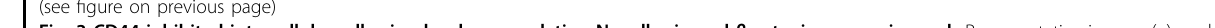
Fig. 3 CD44 inhibited intercellular adhesion by downregulating N-cadherin and β -catenin expression. a , b Representative images ( a ), and quanti fi cation ( b ) of heterotypic intercellular adhesion (hetero adhesion), heterotypic cell clustering (hetero cluster) formed between CCRF-CEM (red) and isogenic cells, and homotypic cell clustering (homo cluster) formed between isogenic tumor cells. Heterotypic adhesion = CCRF-CEM adhered to PLC/PRF/5/total PLC/PRF/5 cells. For heterotypic cluster, the cluster rate = cells in cluster/total cells, the CCRF rate = CCRF-CEM in cluster/total CCRF- CEM, and the CCRF/PLC = CCRF-CEM in cluster/total PLC/PRF/5. Homotypic cluster = percentage of PLC/PRF/5 cells in cluster. The cell cluster was de fi ned as a cell colony that contains >6 cells. Scale bar = 50 μ m. Data are means ± SD of six images of 20× objective. n > 1000 cells analyzed for each cell. * P < 0.05; ** P < 0.01; *** P < 0.001; **** P < 0.0001. c Expression of adhesion molecules upon CD44 overexpression or CD44 knockdown detected by Western blot. The β -actin was used as a loading control. d Interaction between N-cadherin and β -catenin analyzed by co-immunoprecipitation blot. e Representative images depict the subcellular localization of N-cadherin (green), β -catenin (red), and CD44 (purple) in PLC/PRF/5 cells by confocal microscopy. Scale bar, 10 µm. f The relative fl uorescent intensity on line 1 and line 2 in e quanti fi ed by line scanning. g Images showing heterotypic intercellular adhesion (hetero adhesion) and heterotypic cell clustering (hetero cluster) formed between CCRF-CEM (red) CD44-depleted F6ft cells with β -catenin co-depletion. Scale bars, 50 μ m. h N-cadherin and β -catenin mediate enhanced heterotypic intercellular adhesion (hetero adhesion), heterotypic cell clustering (hetero cluster), and heterotypic CIC formation (hetero CIC) upon CD44 depletion. Data are means ± SD of six images of 20× objective. n > 1000 cells analyzed for each cell. ** P < 0.01; *** P < 0.001; **** P <